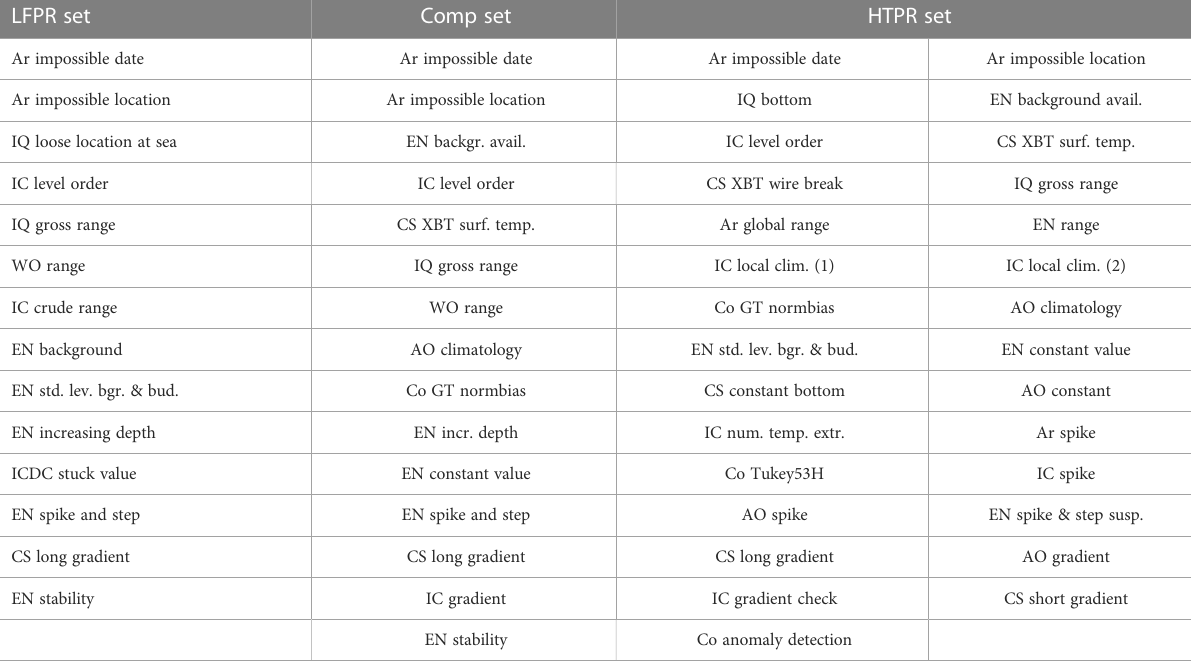
TABLE 4 IQuOD quality control